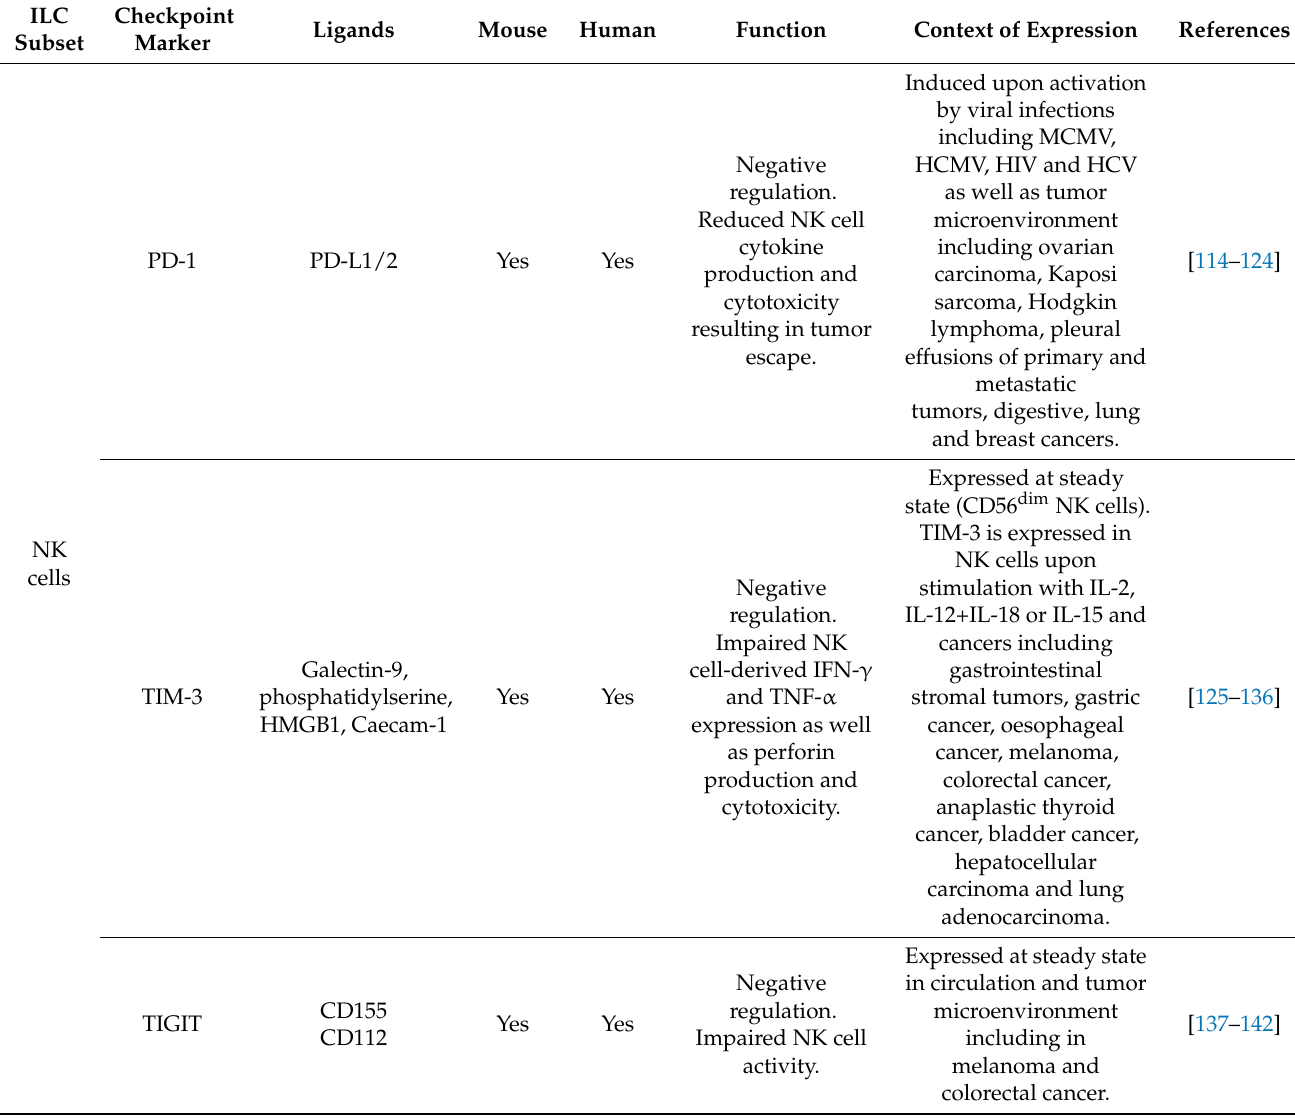
Table 1. Immune checkpoint expression and function according to ILC